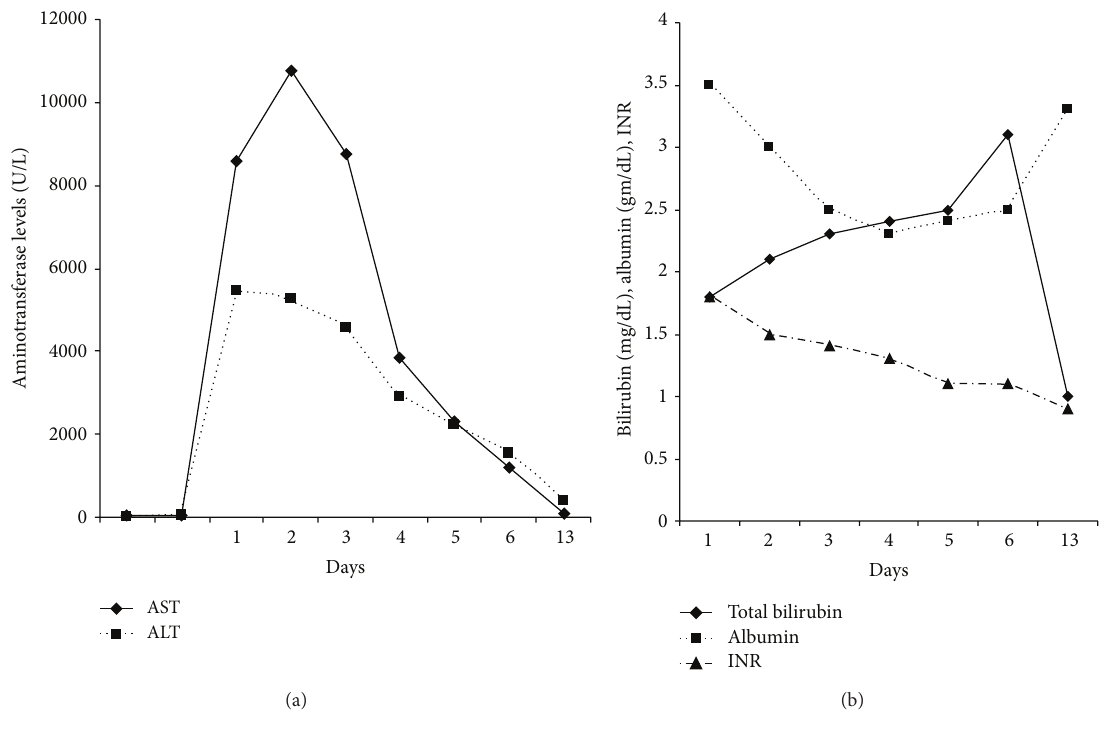
Figure 1: Biochemical markers of hepatocellular